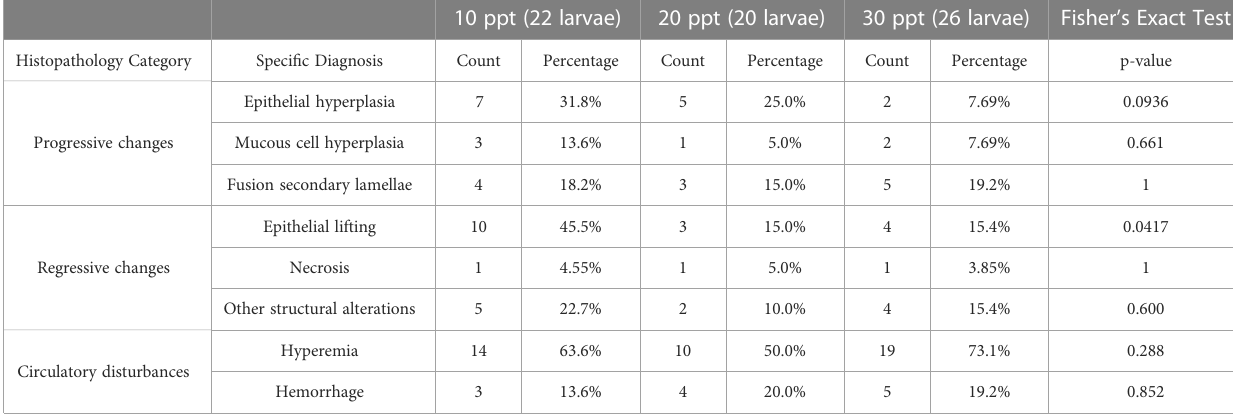
(Supplementary Table 3). Visualization of sample differences using a principal coordinates of analysis showed that there was a TABLE 2 Counts and percentages of histopathological diagnoses associated with progressive and regressive changes, and circulatory disturbances, observed on Florida pompano (Trachinotus carolinus ) larvae secondary gill lamellae for each of the tested salinities (10, 20 and 30